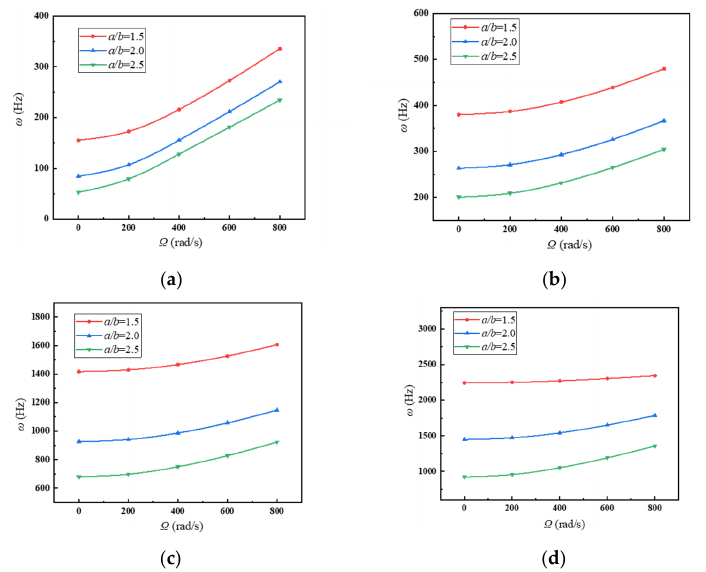
Figure 12. Variations of frequencies with rotating speed under different length-to-width ratio of the plate. ( a ) First frequency; ( b ) second frequency; ( c ) third frequency; ( d ) fourth frequency.